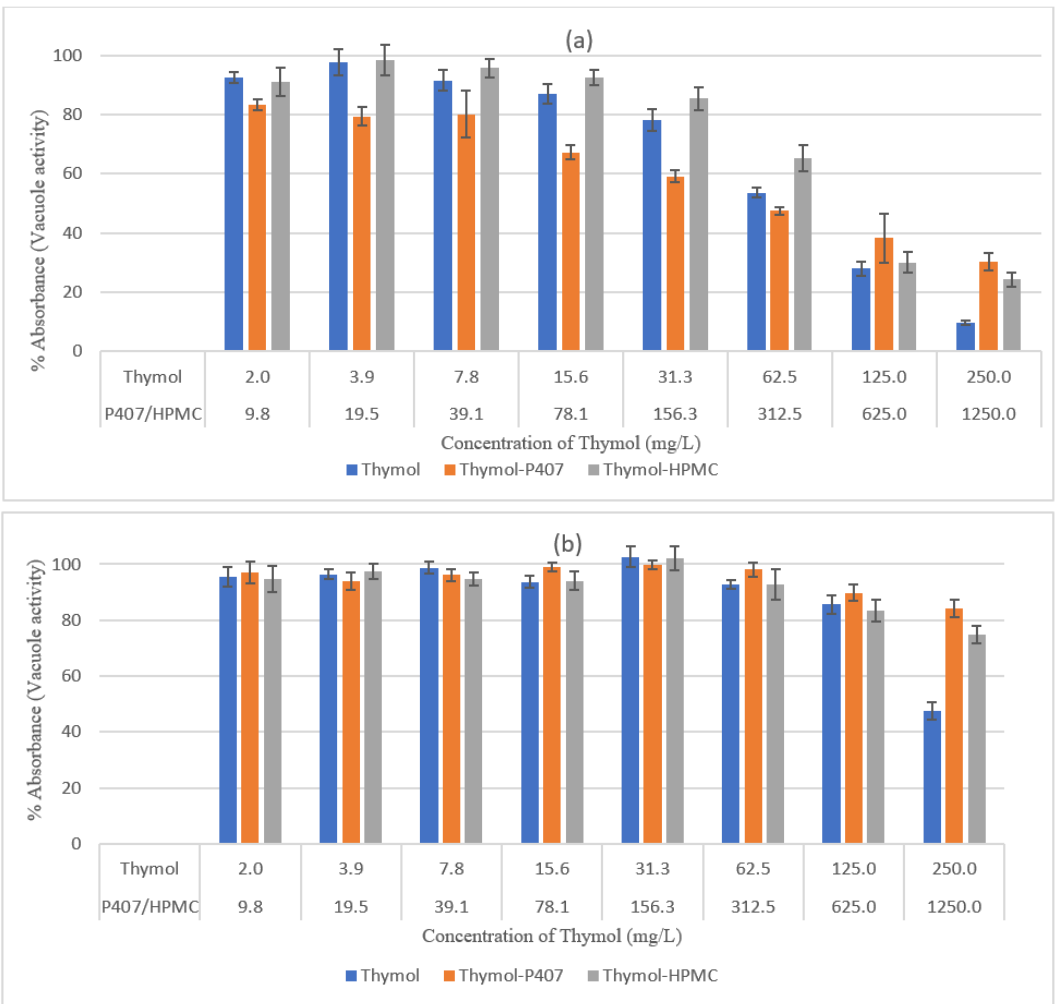
Figure 4. Effect of thymol on C. albicans biofilms using neutral red uptake assay ( a ) 4 h, ( b ) 24 h, ( n = 6) for 2 h at 37 °C. Each point represents the mean percentage ± SE.